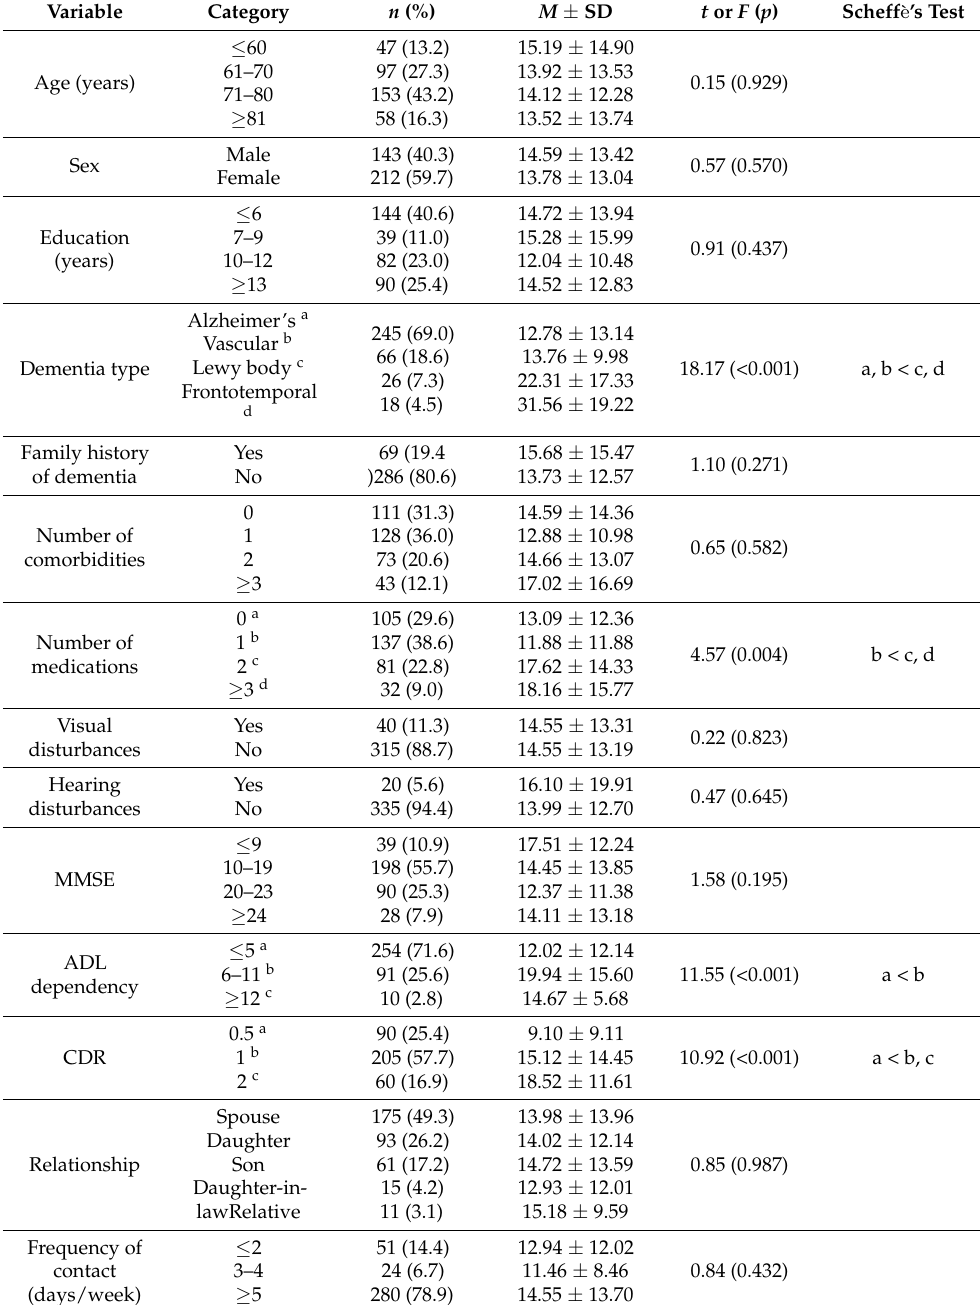
Table 2. Differences in BPSD per Participants’ Characteristics at the First Time of Dementia Diagnosis ( N =